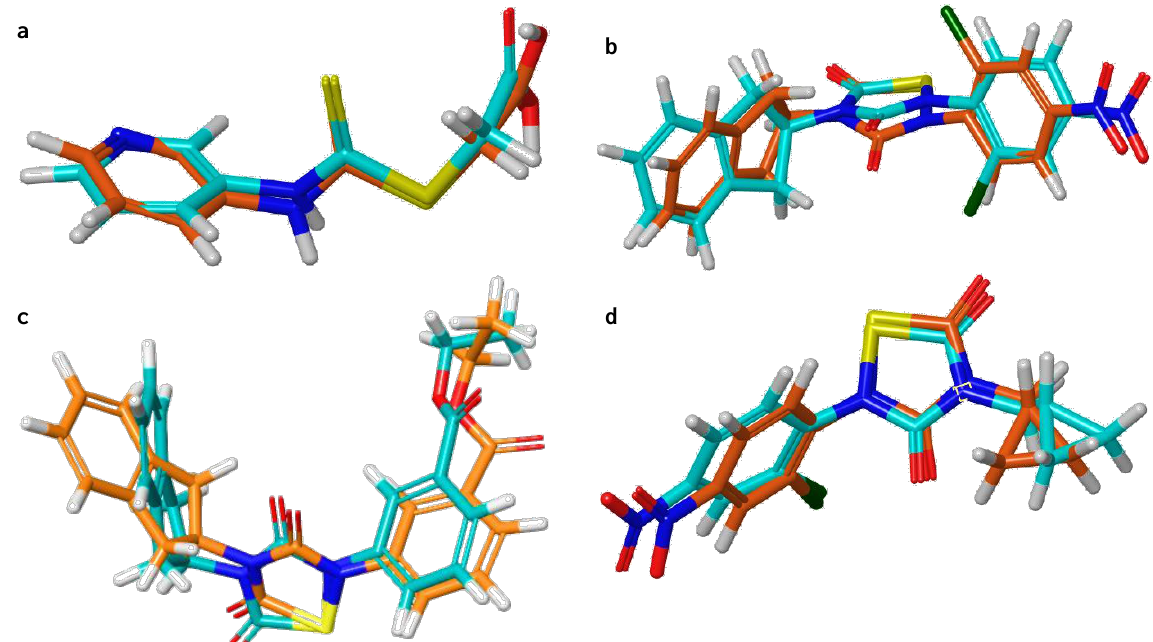
Figure S11 . Superposition of conformations of (a) inhibitor 10 after MD simulation (orange) and best dock pose (turquoise) (RMSD: 1.23 Å) (b) inhibitor 19 after MD simulation (orange) and best dock pose (turquoise) (RMSD: 1.53 Å) (c) inhibitor 21 after MD simulation (orange) and best dock pose (turquoise) (RMSD: 1.35 Å) (d) inhibitor 25 after MD simulation (orange) and best dock pose (turquoise) (RMSD: 0.77